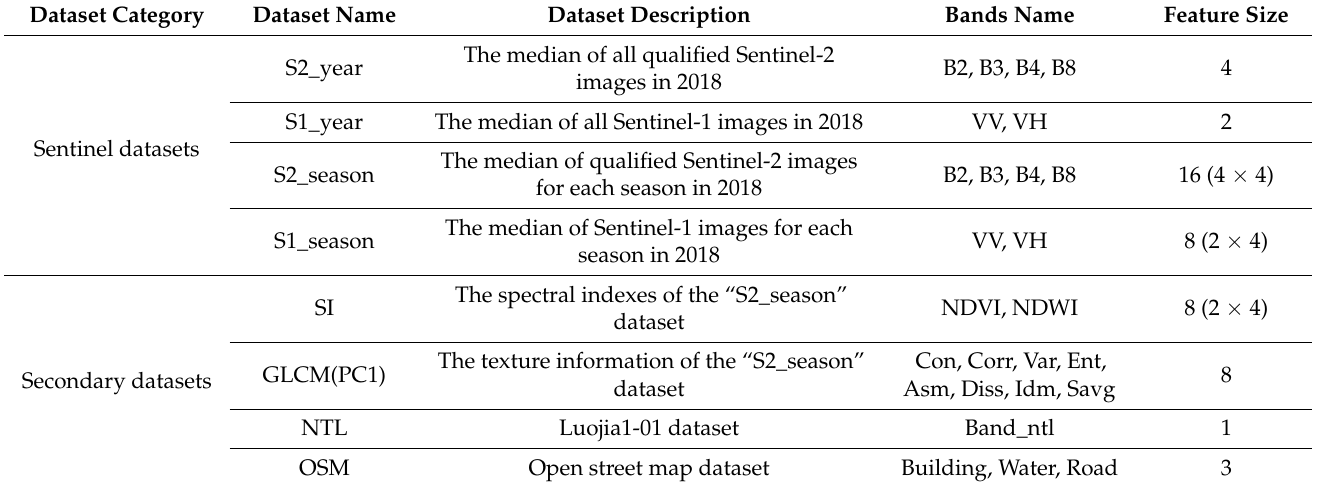
Table 2. The used datasets in this study.